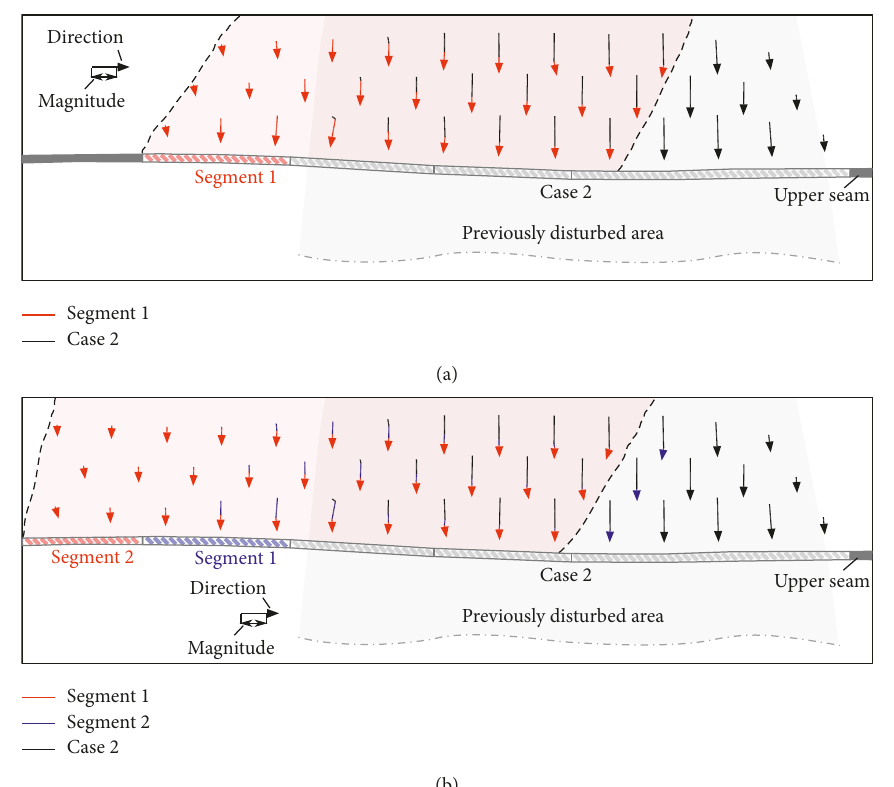
Figure 8: (a, b) Deformation pattern after extraction of different segments of the extension part in Case